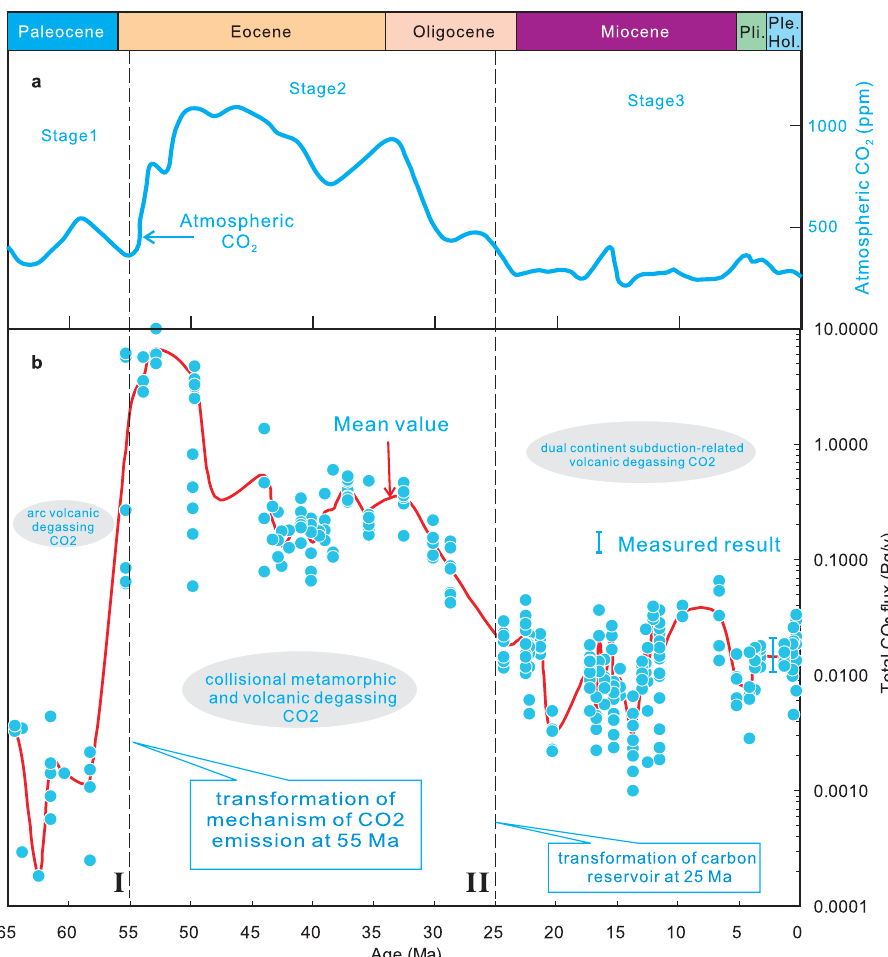
Fig. 7 Three-stage evolution of the quantitative calculation results of CO 2 fl ux derived from India-Asia collision-induced degassing using CCFM and global atmospheric CO 2 level variations in the Cenozoic. a Three-stage variations of atmospheric CO 2 concentrations in the Cenozoic. The data are from ref. 2 . b Our CCFM modelling results, indicating a similar three-stage pattern of rates of CO 2 released from the India-Asia collisional orogen in the Cenozoic. The measured data for the CO 2 degassing fl ux in Tibet 45,51 , which is shown by a blue bold line, is consistent with our modelling calculation results. Each fi lled blue dot in ( b ) denotes a calculation result of India-Asia collision-related mantle degassing (including the magmatic and metamorphic CO 2 outgassing) rate by CCFM based on a set of geochemical data (including major element, trace element and Sr – Nd – Pb isotope composition) of each sample from 287 samples (for detailed calculation procedures see “ Methods ” and Supplementary Data 2), which have been distributed in 55 volcanic fi elds in Tibetan Plateau in the Cenozoic (Fig. 1). The mean value of the collision-induced CO 2 degassing rates in each volcanic fi eld is shown as a solid red curve (for detailed calculation results of the mean values see Table 1). 1 Pg = 10 15 g. The black dashed lines labelled I and II denote the fi rst-step and second-step transformation of the deep carbon cycle processes during India-Asia collision, respectively. I: the fi rst-step transformation from continental arc magmatism-induced CO 2 degassing to collision-related metamorphic and magmatic CO 2 emission; II: the second-step transformation from a carbonate platform-supplying carbon reservoir to a subducting silicate-rich continental material-supplying carbon